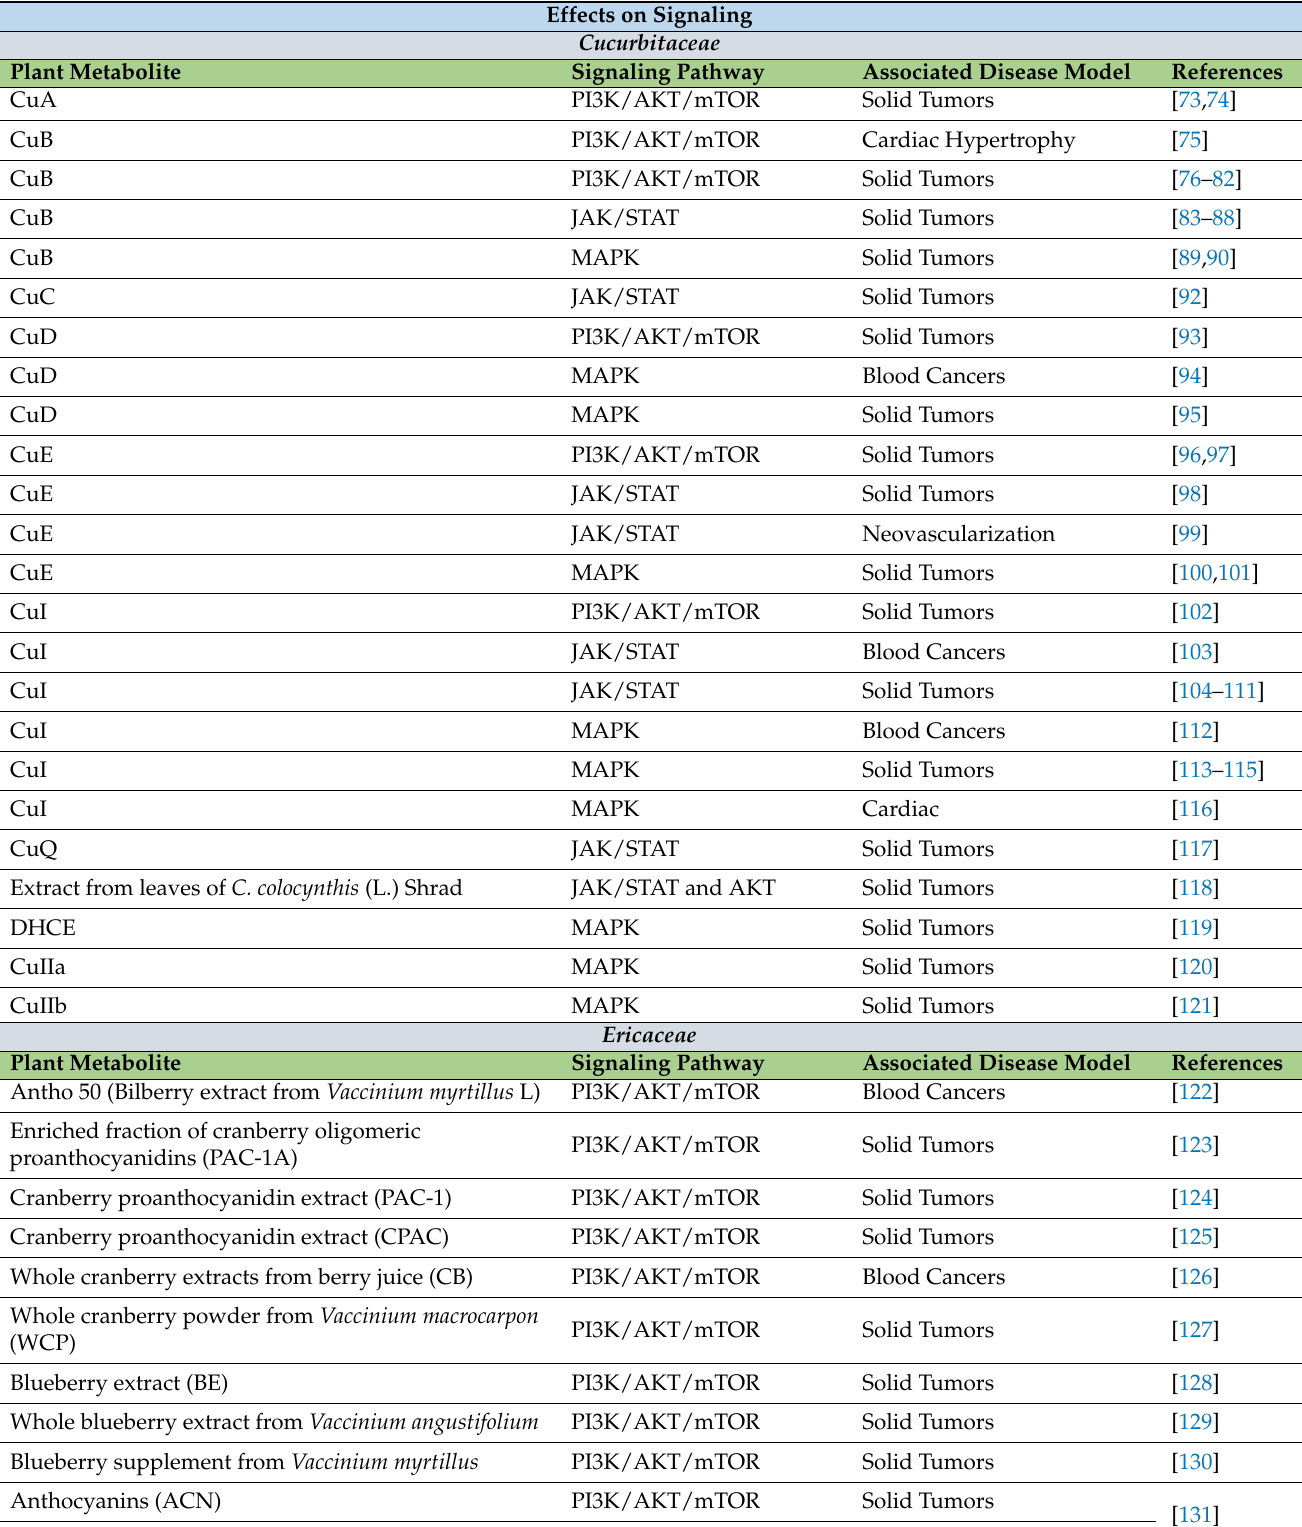
Table 6. Summary of Effects on Signaling across the three plant